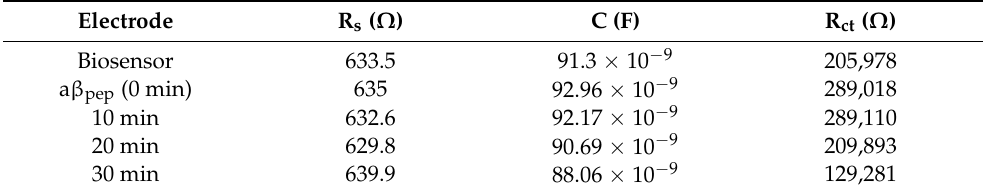
Figure 9. EIS results monitoring the impact of EPPS on the a β pep at different time intervals display in ( a ) Nyquist plots and ( b ) Normalization of R ct . (n = 3; three data points shown). Table 4. EIS parameters of the anti-a β /SAM/ICE biosensor after incubating with a β pep , and then conduct to treatment with EPPS at different time intervals, extrapolated by fitting the measured spectra in Figure 9a to the equivalent circuit model of Randle.